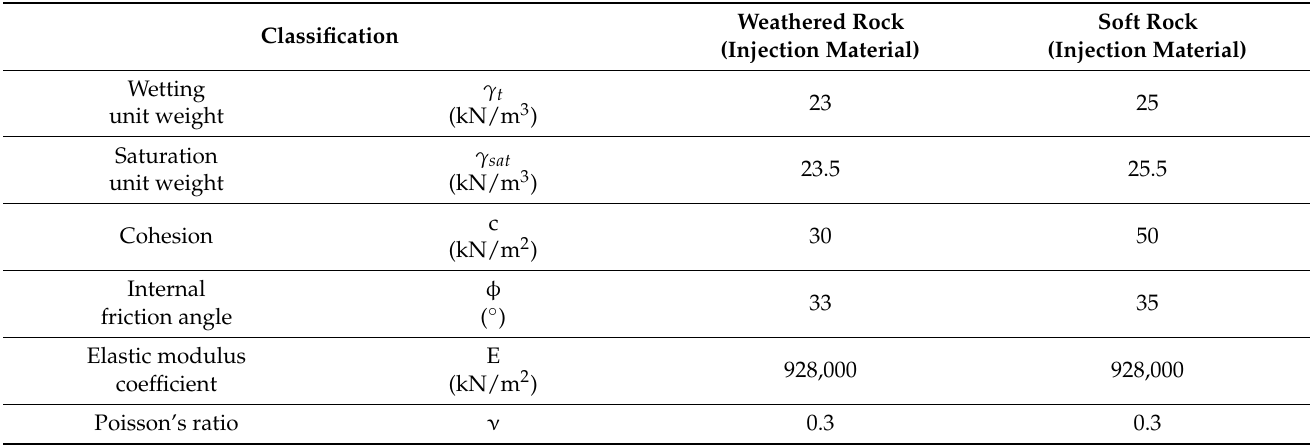
Table 10. Applied material properties of the grout injected into the weathered rock and soft